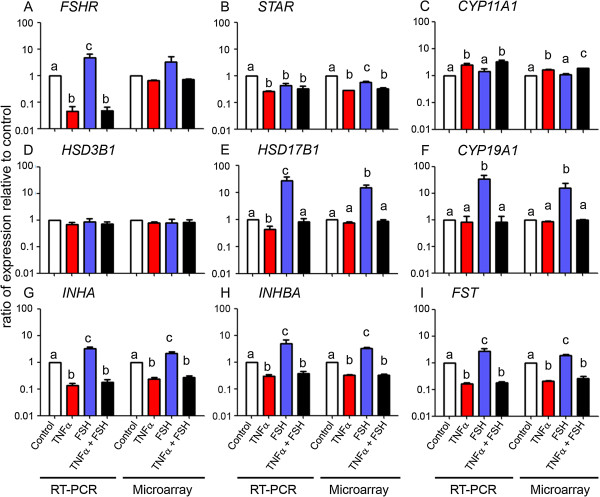
Gene expression by qRT-PCR. The data are shown on a log scale as the mean ± SEM (n = 4 each, except microarray control group n = 3) for the ratio of gene expression with treatments relative to control (set at 1.0). qRT-PCR values were determined from the ΔΔCt for the target genes (A – I), relative to β-actin (ACTB), and the microarray values are signal intensities (normalised but not log transformed). Significantly different results for treatments used one-way ANOVA with Fisher’s LSD post hoc test; P < 0.05.